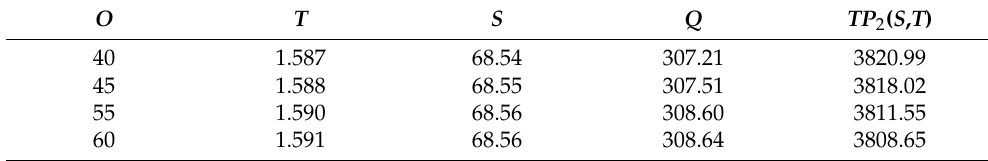
Table 7. Impact of ordering cost ( O ) .